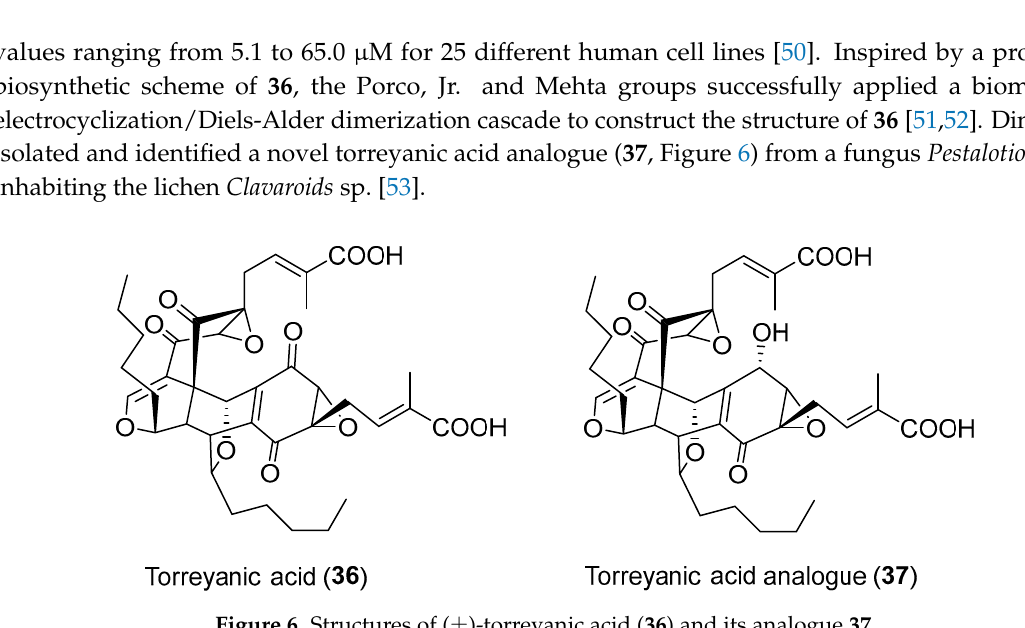
Figure 6. Structures of (±)-torreyanic acid ( 36 ) and its analogue 37 .